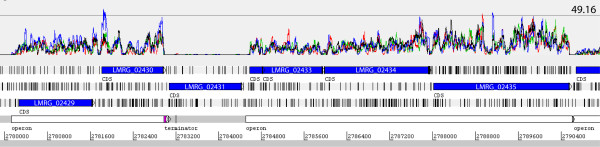
View of RNA-Seq data using the Artemis genome browser. This region of the 10403S chromosome includes six coding genes, i.e. LMRG_02429 to LMRG_02435, and the 5' end of LMRG_02436; genes are represented as blue arrows. The top part of the figure shows normalized RNA-Seq coverage (i.e. the number of reads that match an annotated gene after normalization across runs) with red and blue lines representing the two 10403S replicates and the green and black lines representing the ΔsigB strain. The horizontal line indicates a normalized RNA-Seq coverage of 49.16 reads. The middle part of the figure shows the three positive frames of translation with the coding regions and vertical black bars representing stop codons. The last line shows putative operons (white bars), a terminator (purple bar) downstream of LMRG_02430 and the chromosome coordinates. Notice the difference in coverage between LMRG_02431 (downstream of the terminator) and the other genes. All genes in the figure have sequencibility of 100% (See Additional file 1: Sequencibility text file for a complete sequencibility plot).